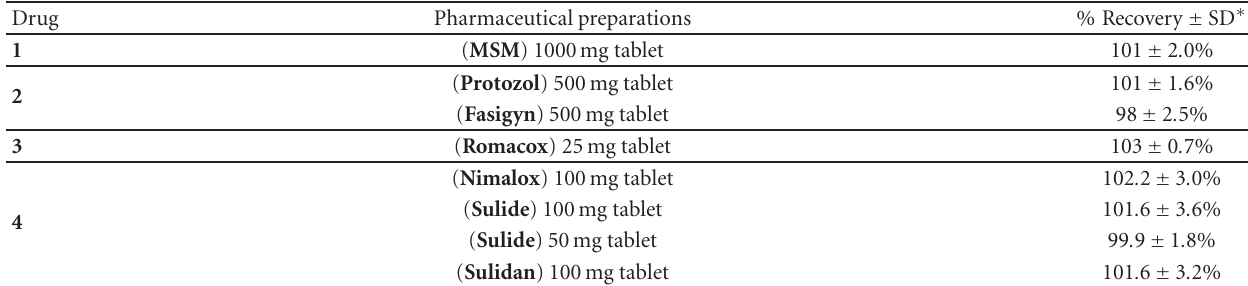
Table 6: Results of the recovery experiments of 1–4 in di ff erent pharmaceutical